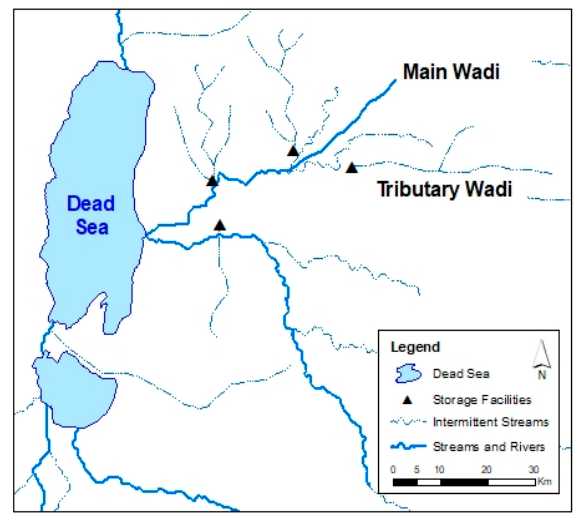
Figure 3. Potential surface storage facilities are very appropriate to collect flood water, but no potential for MAR, except some bank storage, because the groundwater of all aquifers in the area is effluent as a result of the strong slopes of the escarpment and the Dead Sea being the ultimate base level of all surface and groundwater resources of the Dead Sea catchment.